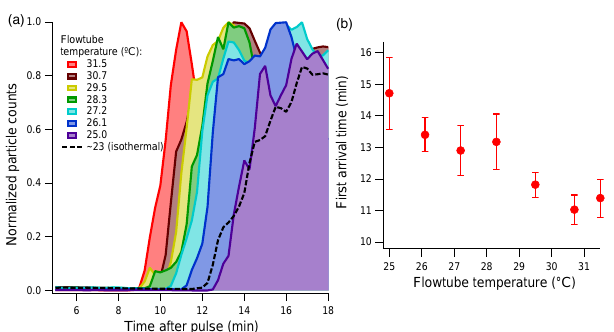
Figure 12. Non-isothermal effects on particle RTD. The water jacket temperature was raised systematically against the room tem- perature ( ∼ 23 ◦ C). (a) Normalized ammonium sulfate particle counts recorded at the exit are plotted against time after a pulse is introduced at the inlet. The experiment at each temperature is repeated three to four times. The results from a set of isothermal ex- periments are also included (dashed line) for reference. (b) Arrival times of the first major peak of each experiment.